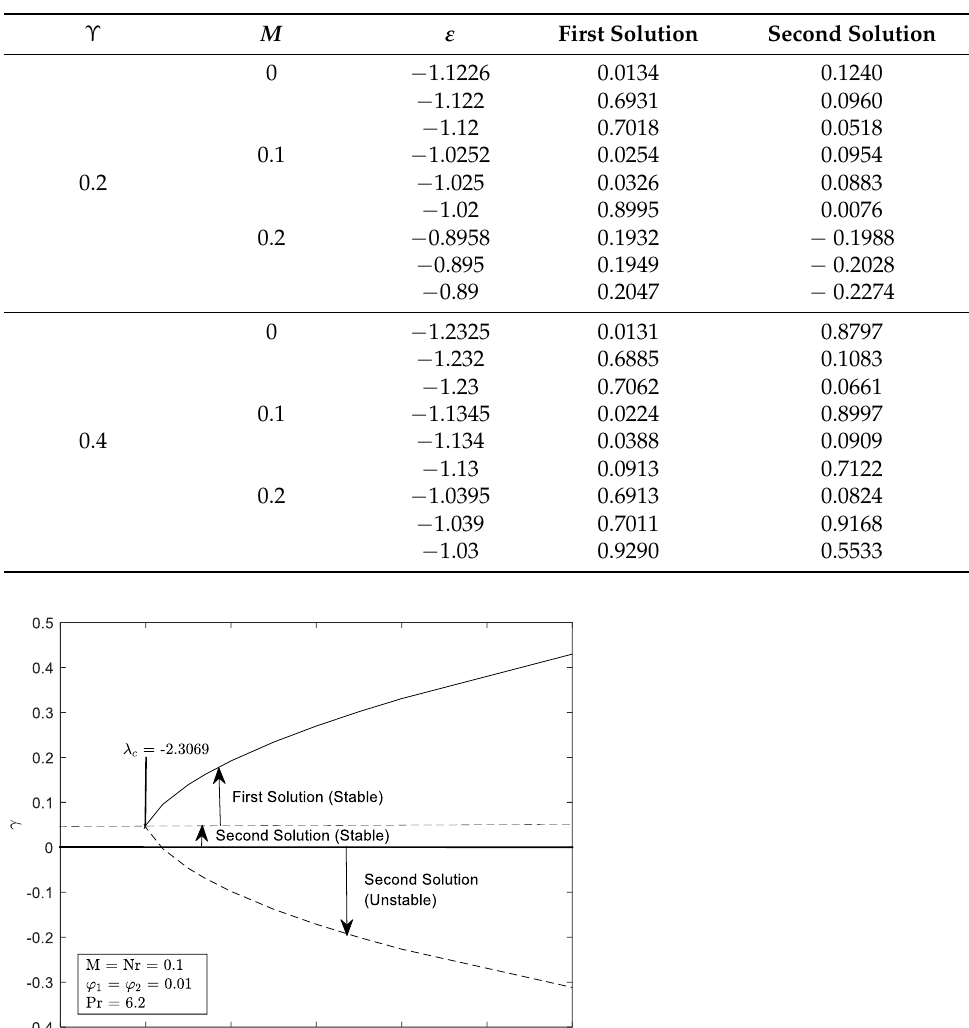
Table 5. Least eigenvalues γ for selected Υ with several values of M when ϕ 1 = ϕ 2 = 0.01, λ = − 0.4 and Nr = 0.1.